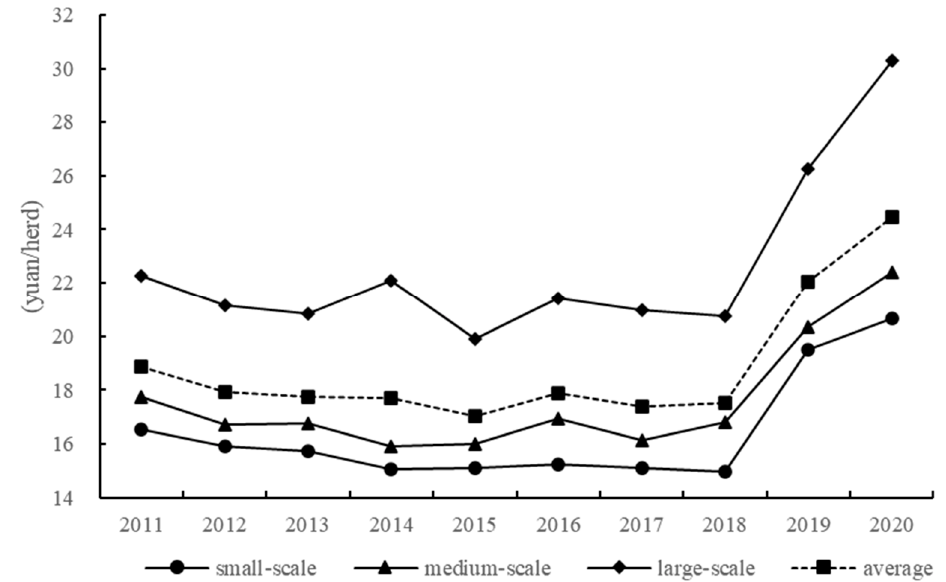
Figure 4. Annual medical and epidemic prevention costs of hog production of different scales in China from 2011 to 2020.